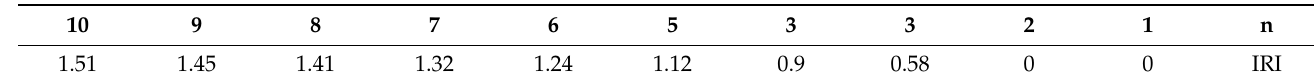
Table 27. IIR figures.